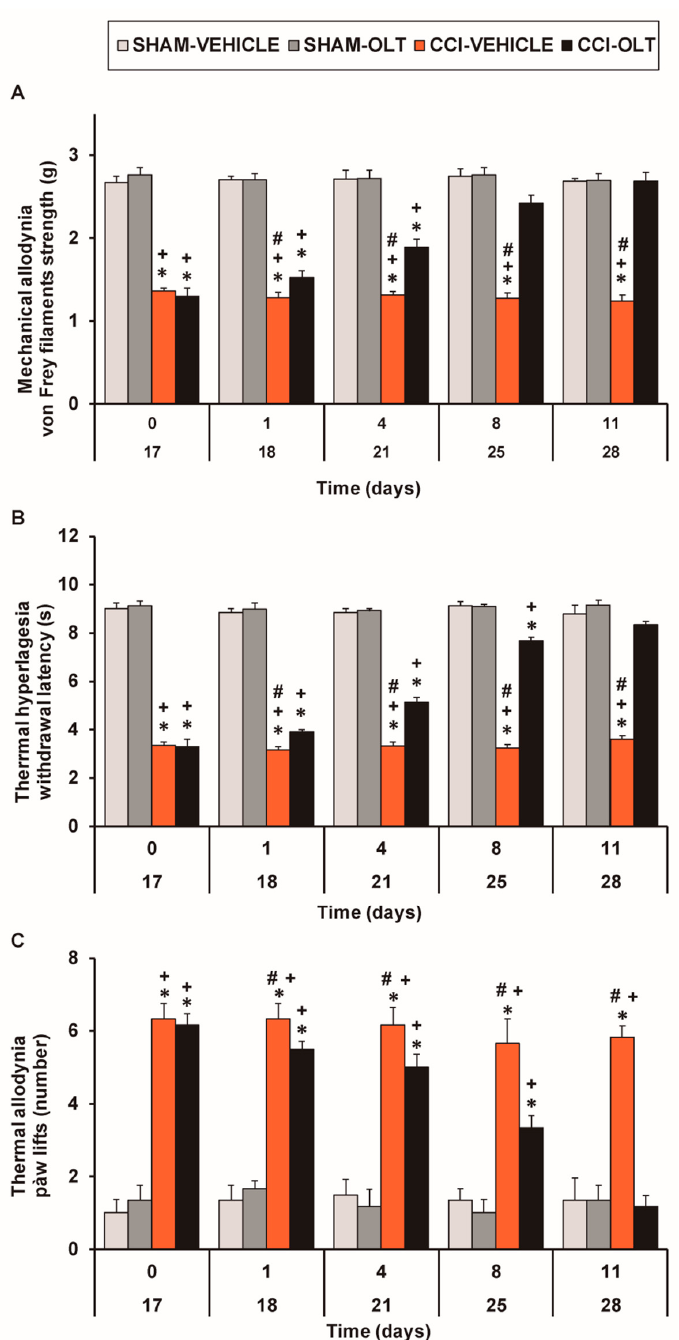
Figure 1. Repeated treatment with oltipraz reduces mechanical allodynia, thermal hyperalgesia, and thermal allodynia in CCI-injured mice. The development of ( A ) mechanical allodynia, ( B ) thermal hyperalgesia, and ( C ) thermal allodynia in the ipsilateral paw of the CCI-injured or sham-operated (SHAM) mice treated with 10 mg / kg oltipraz (OLT) or vehicle for 11 consecutive days is shown. The e ff ects of oltipraz were evaluated at days 18, 21, 25, and 28 after surgery. For each test and time evaluated, * denotes significant di ff erences vs. sham-operated mice treated with vehicle, + denotes significant di ff erences vs. sham-operated mice treated with oltipraz, and # denotes significant di ff erences vs. CCI-injured mice treated with oltipraz ( p < 0.05; one-way ANOVA followed by the Student-Newman-Keuls (SNK) test). Results are presented as the mean ± standard error of the mean (SEM); n = 6–8 animals per experimental group.